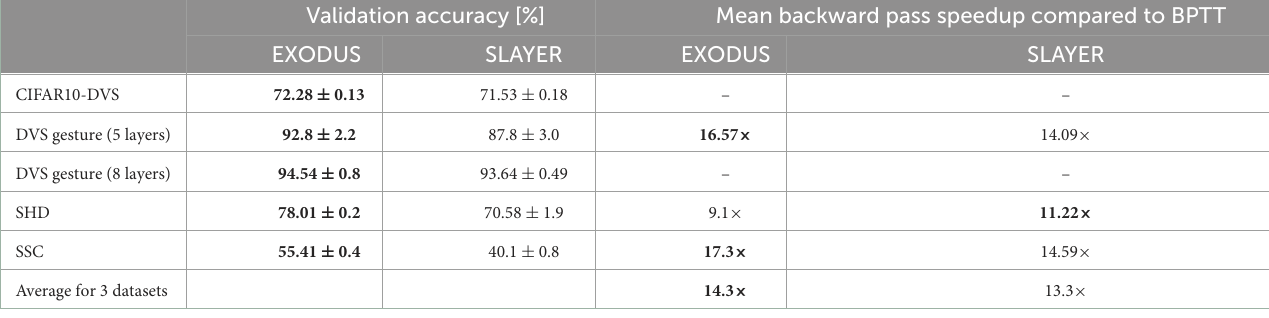
TABLE 1 Validation accuracy and backward pass speedup per epoch for different